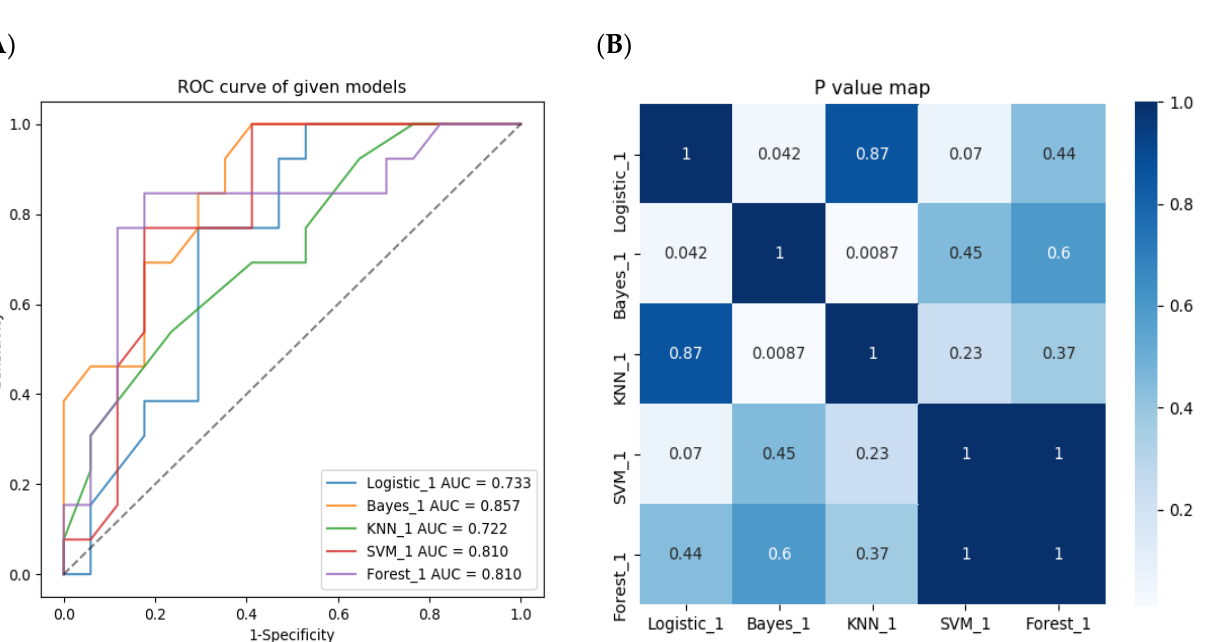
Figure 7. The performance evaluation of the five radiomics models in the external validation group. ( A )The Bayes model had the maxium AUC, followed by RF model and SVM model. ( B ) Delong test showed there were no significant difference between RF, SVM and Bayes with AUCs each other.